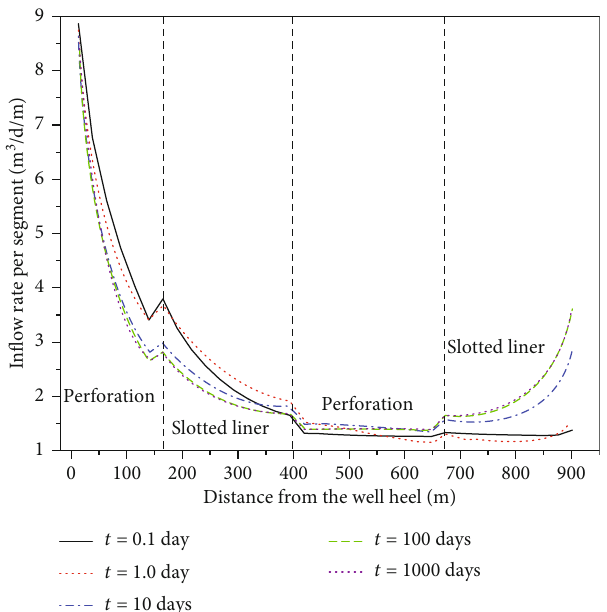
Figure 10: In fl ow rate distribution of di ff erent well completions at di ff erent